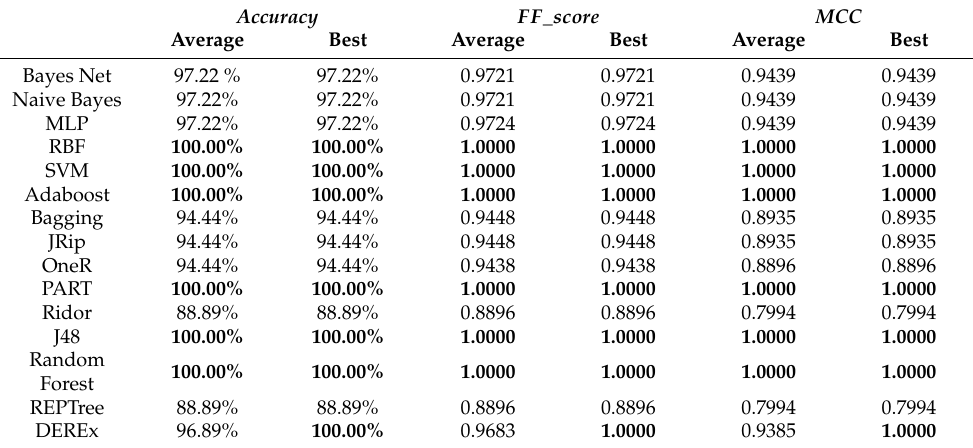
Table 5. The numerical results for the 2-Class